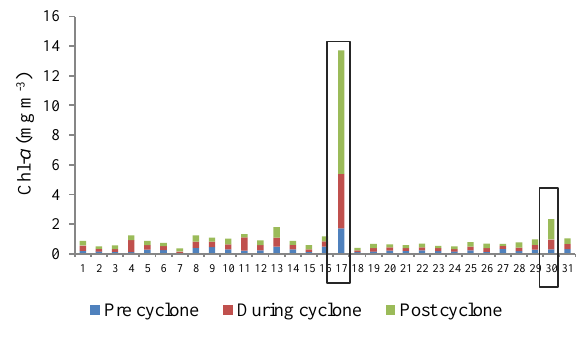
Figure 4. Observation of chl- a before, middle and after the passage of 31 cyclone tracks. The cyclone cases information is specified in Table 1 in ascending order as per the year occurred.